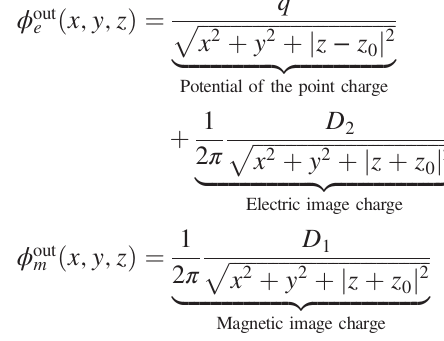
ffiffiffiffiffiffiffiffiffiffiffiffiffiffiffiffiffi p ffiffiffiffiffiffiffiffiffiffiffiffiffiffiffiffiffiffi a þ d − γ